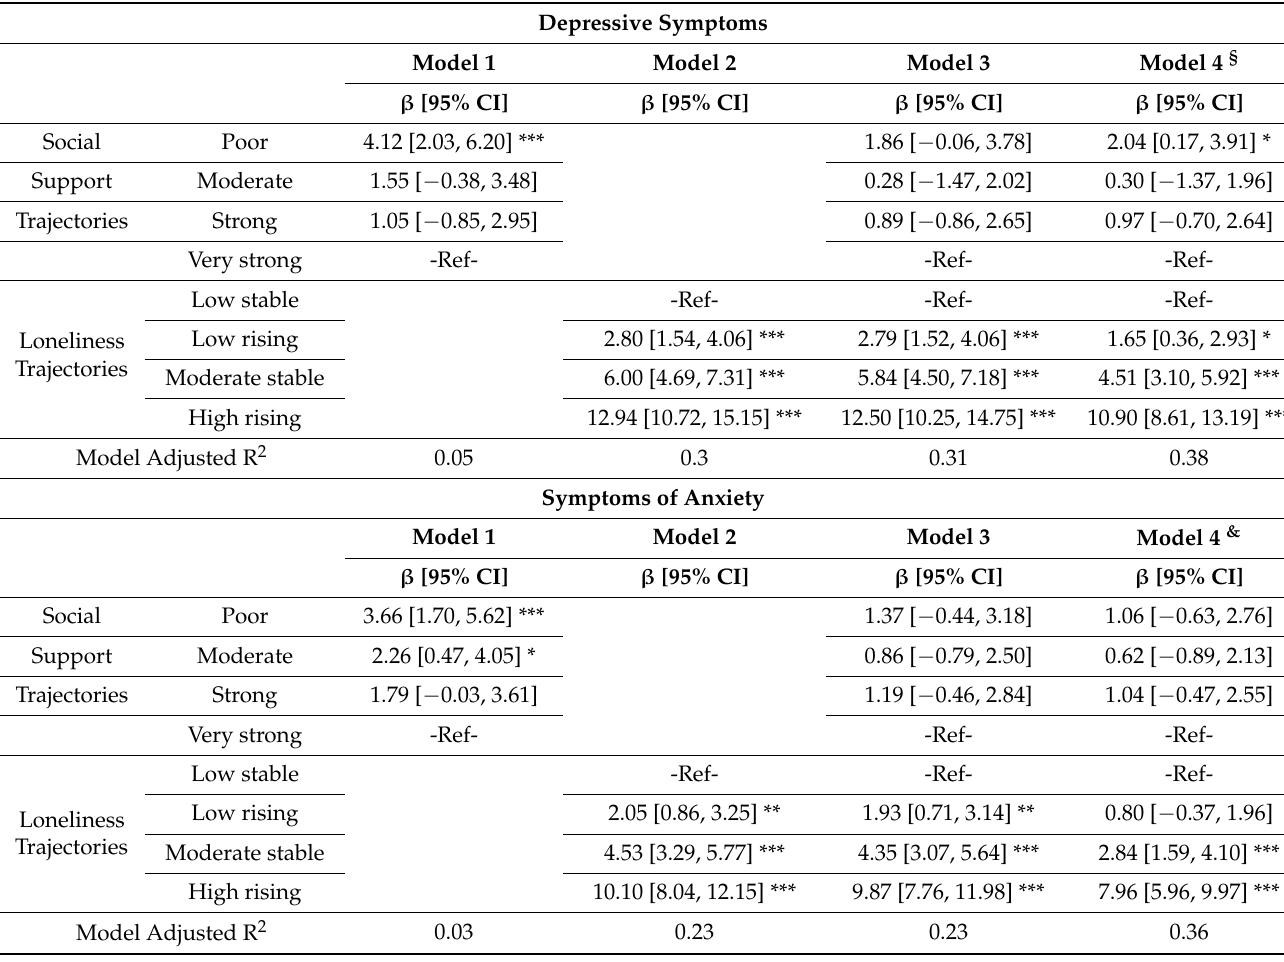
Table 2. The association of social support and loneliness trajectories with symptoms of depression (n = 364) and anxiety (n = 369) in French participants of the COMET